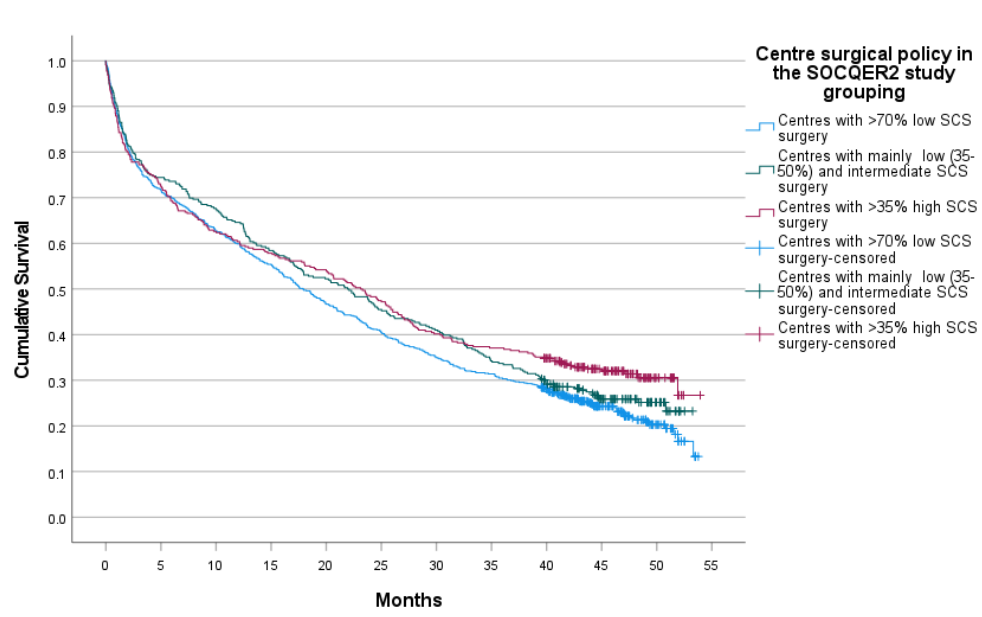
Figure 3. Survival of whole cohort of advanced ovarian cancer patients in centres grouped by surgical surgical policy.